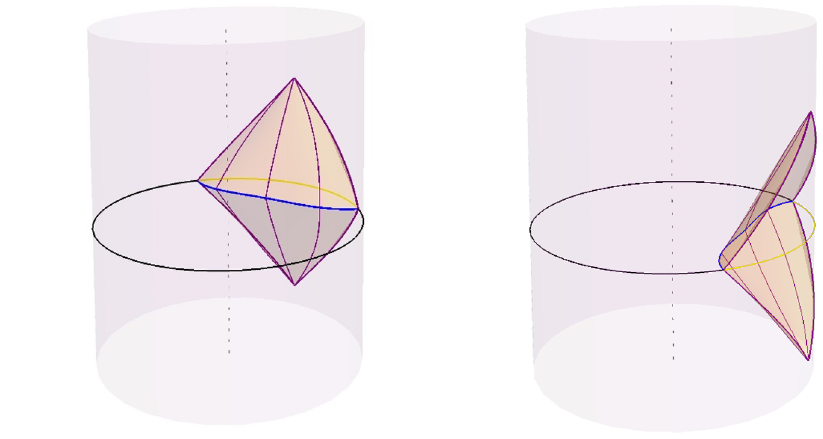
Figure 5. Plot of the lightsheet bounding the entanglement wedge corresponding to an interval, shown in yellow, that covers less than half of the boundary with r 0 = 1 : 1, (cid:17) = 0 and (cid:11) = 1 = 3. A few light rays generating the lightsheet are drawn in